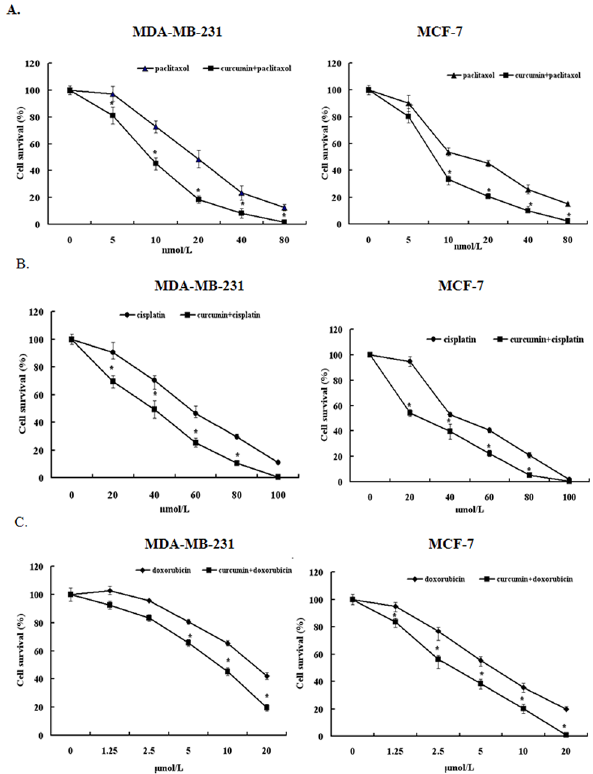
Fig 1. Curcumin and chemotherapeutic drugs (paclitaxol, cisplatin, and doxorubicin) alone and together inhibited the cell viability of MDA-MB-231 and MCF-7 cells. Cells were treated with different concentrations of paclitaxel, cisplatin, and doxorubicin and/or 40 μ mol/L curcumin (IC 50 ). An MTT assay was used to determine cell viability at 48 h. Data are presented as means ± SD (n = 3). * P < 0.05 and compared with untreated